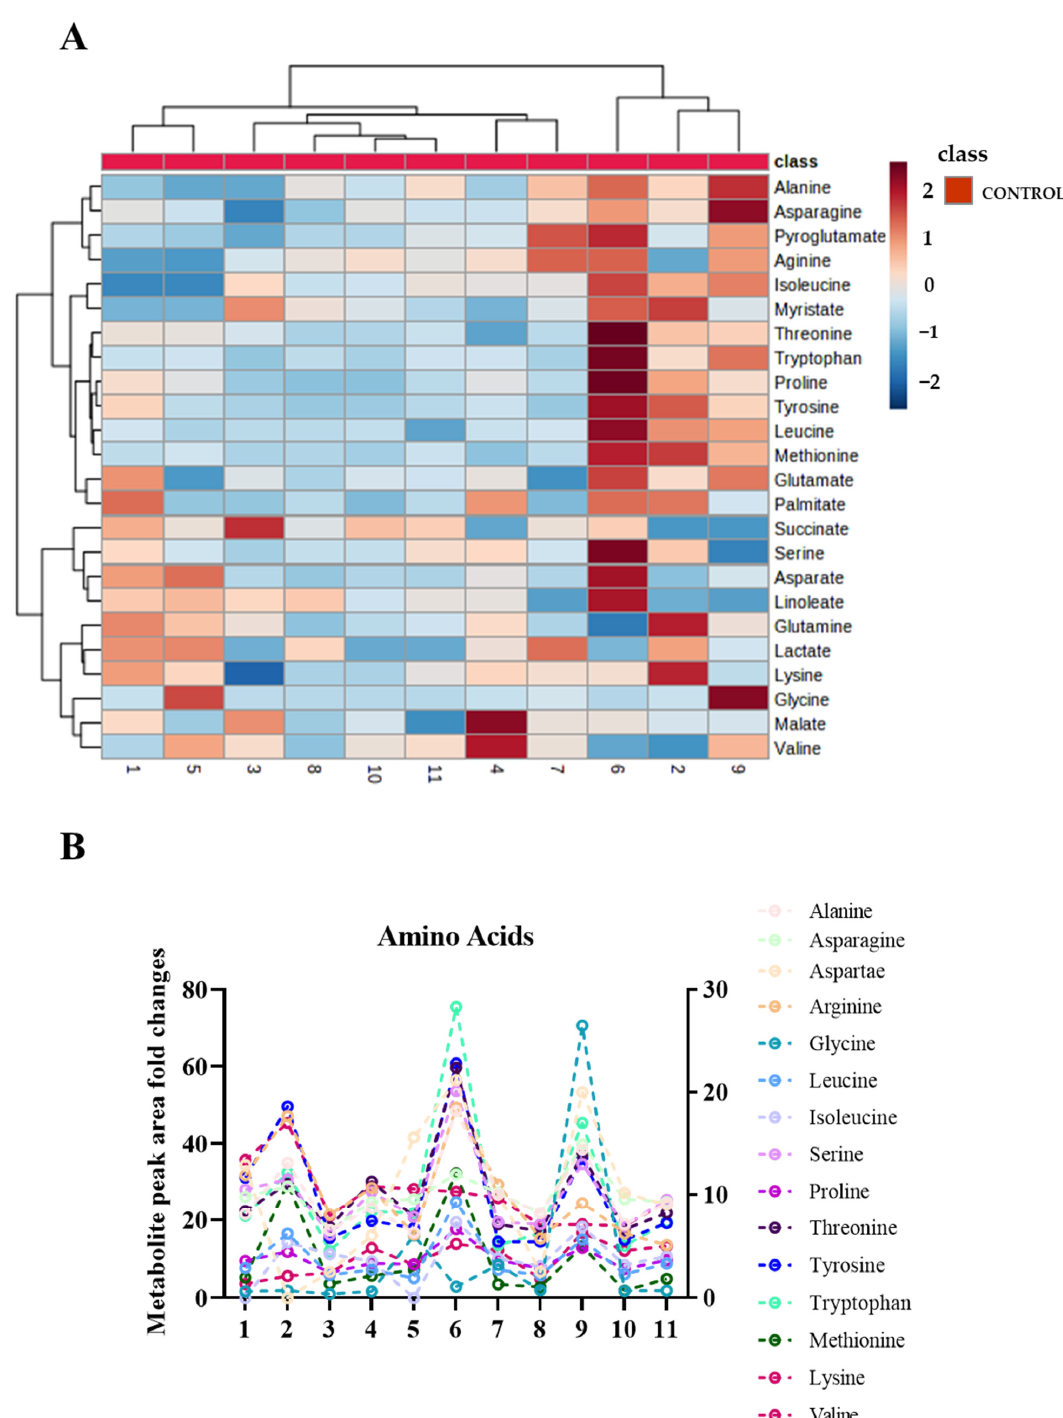
Figure 3. Sweat EVs exhibit metabolic qualities. ( A ) Heatmap illustrating the metabolite pattern of healthy sweat EVs upon heat exposure. ( B ) Metabolite signatures of the amino acid pathway, including alanine, aspartate, arginine, serine, threonine, tyrosine, tryptophan, and lysine, corresponding to the right y-axis, and glycine, leucine, isoleucine, proline, methionine, and valine, corresponding to the left y-axis. Data are metabolite peak area fold changes ± SEM after normalization to the total concentrations of EVs (particles/mL) and to the negative controls (patch without sweat sample). Healthy participants n =